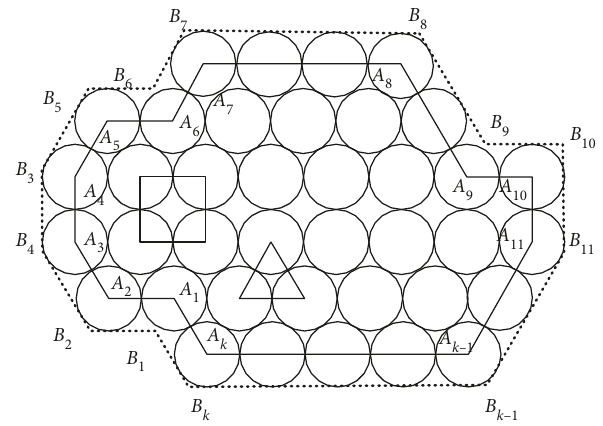
Figure 7: k -sided polygon fiber-clustering